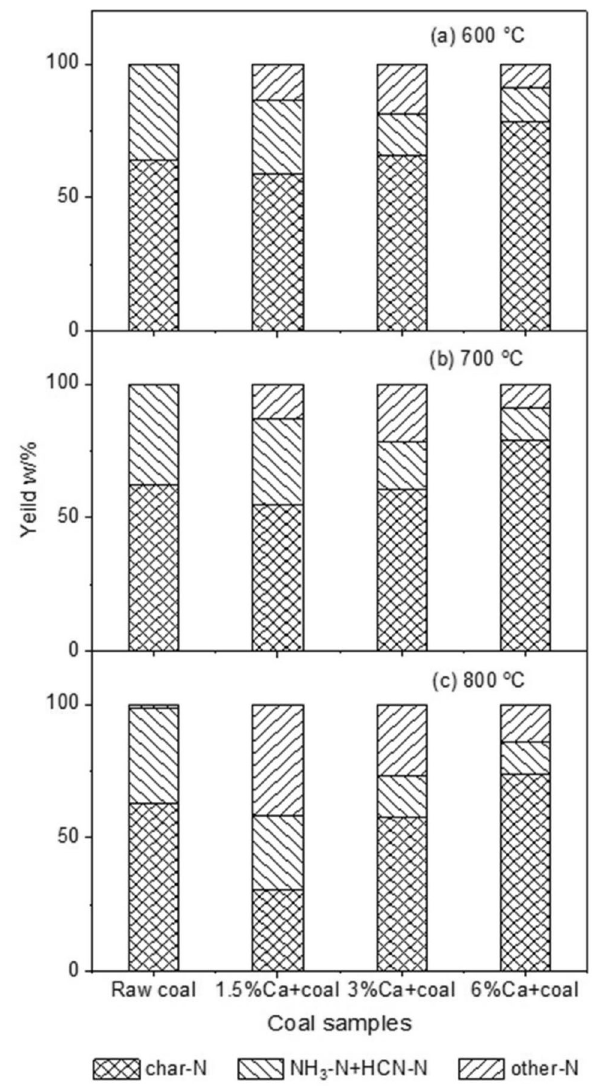
Fig. 5 The distribution of N in char and volatiles during pyrolysis of coal and Ca-loaded coal samples at different